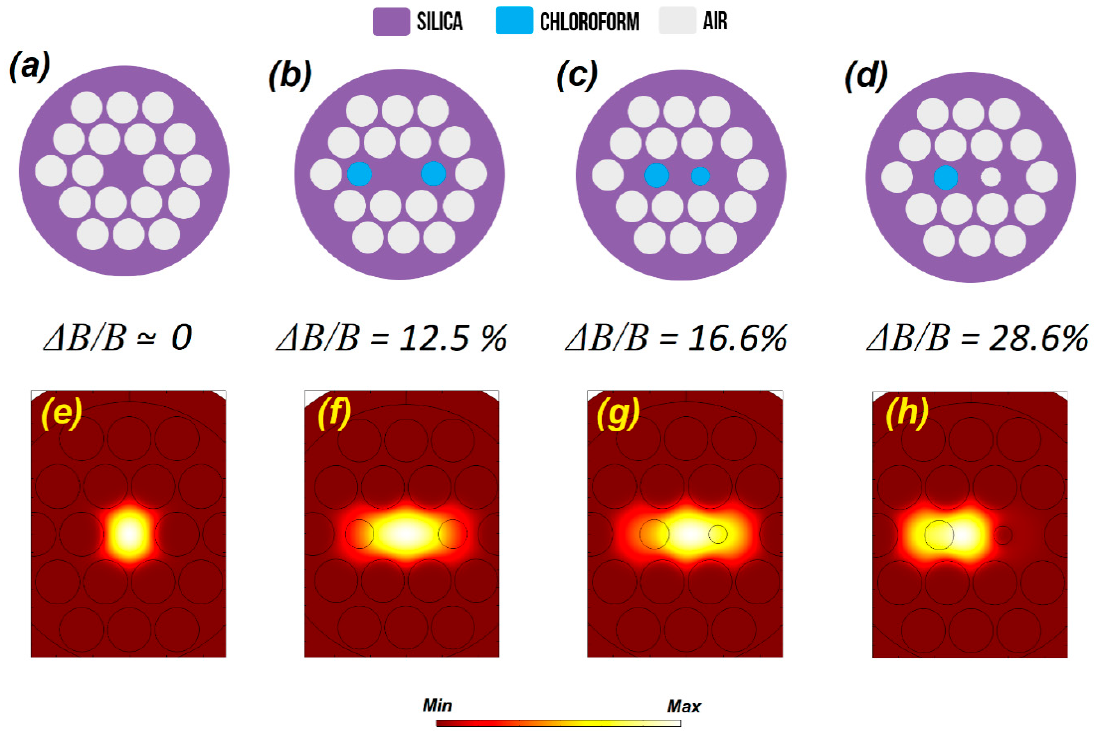
Figure 4. ( a – d ) Birefringence sensitivity and cross section of chloroform-filled PCFs with di ff erent Figure 4. (a)–(d) Birefringence sensitivity and cross section of chloroform-filled PCFs with different design and infiltration patterns. ( e – h ) The corresponding electrical field distribution of the fundamental design and infiltration patterns. (e)–(h) The corresponding electrical field distribution of the guided mode in the PCF core for an x-polarized light excitation at 1200 nm. fundamental guided mode in the PCF core for an x-polarized light excitation at 1200 nm.